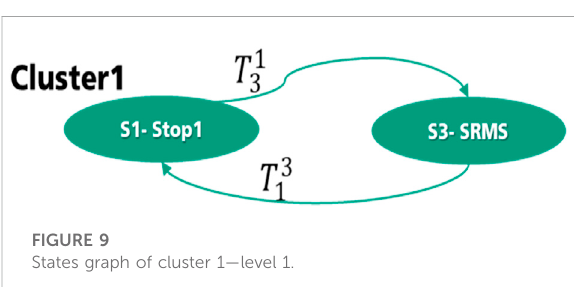
FIGURE 9 States graph of cluster 1 — level 1.